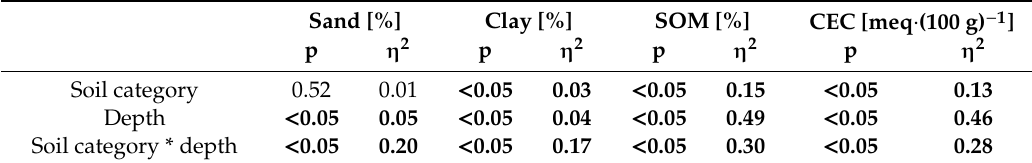
Table 5. Significance (p) and e ff ect size ( η 2 ), testing depth- and soil-related influence on soil parameters (Two-way ANOVA for soil categories undisturbed and disturbed). Significant values appear bold. Sand [%] Clay [%] SOM [%] CEC [meq · (100 g) − 1 ] p η 2 p η 2 p η 2 p η 2 Soil category 0.67 0.00